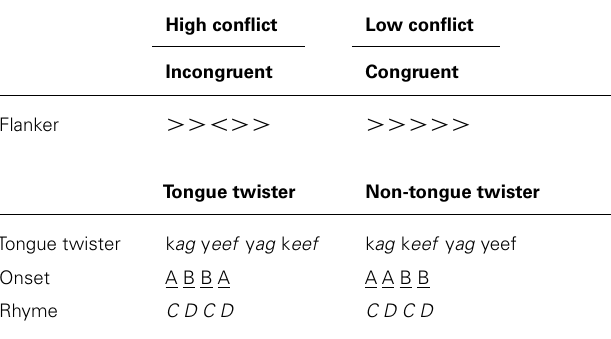
Table 1 | Example stimuli for flanker and tongue twister